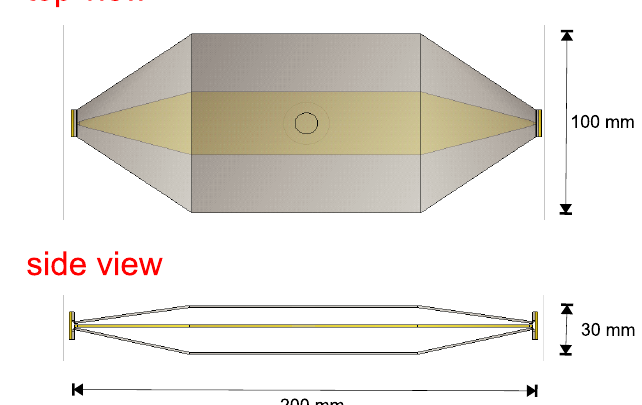
PLoS ONE | www.plosone.org